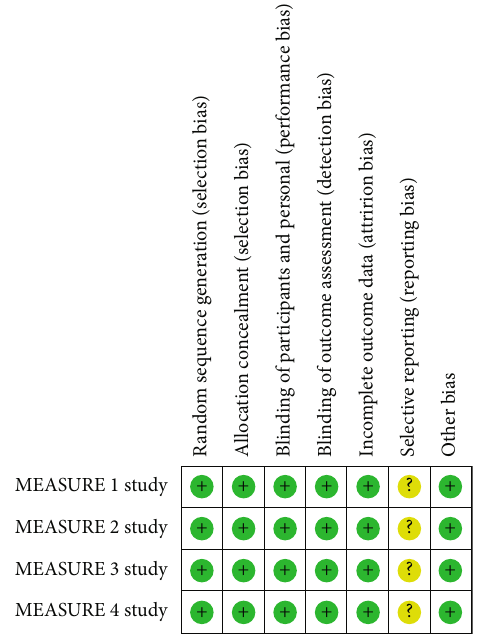
Figure 2: Risk of bias graph: review authors ’ judgement about each risk of bias item for each included